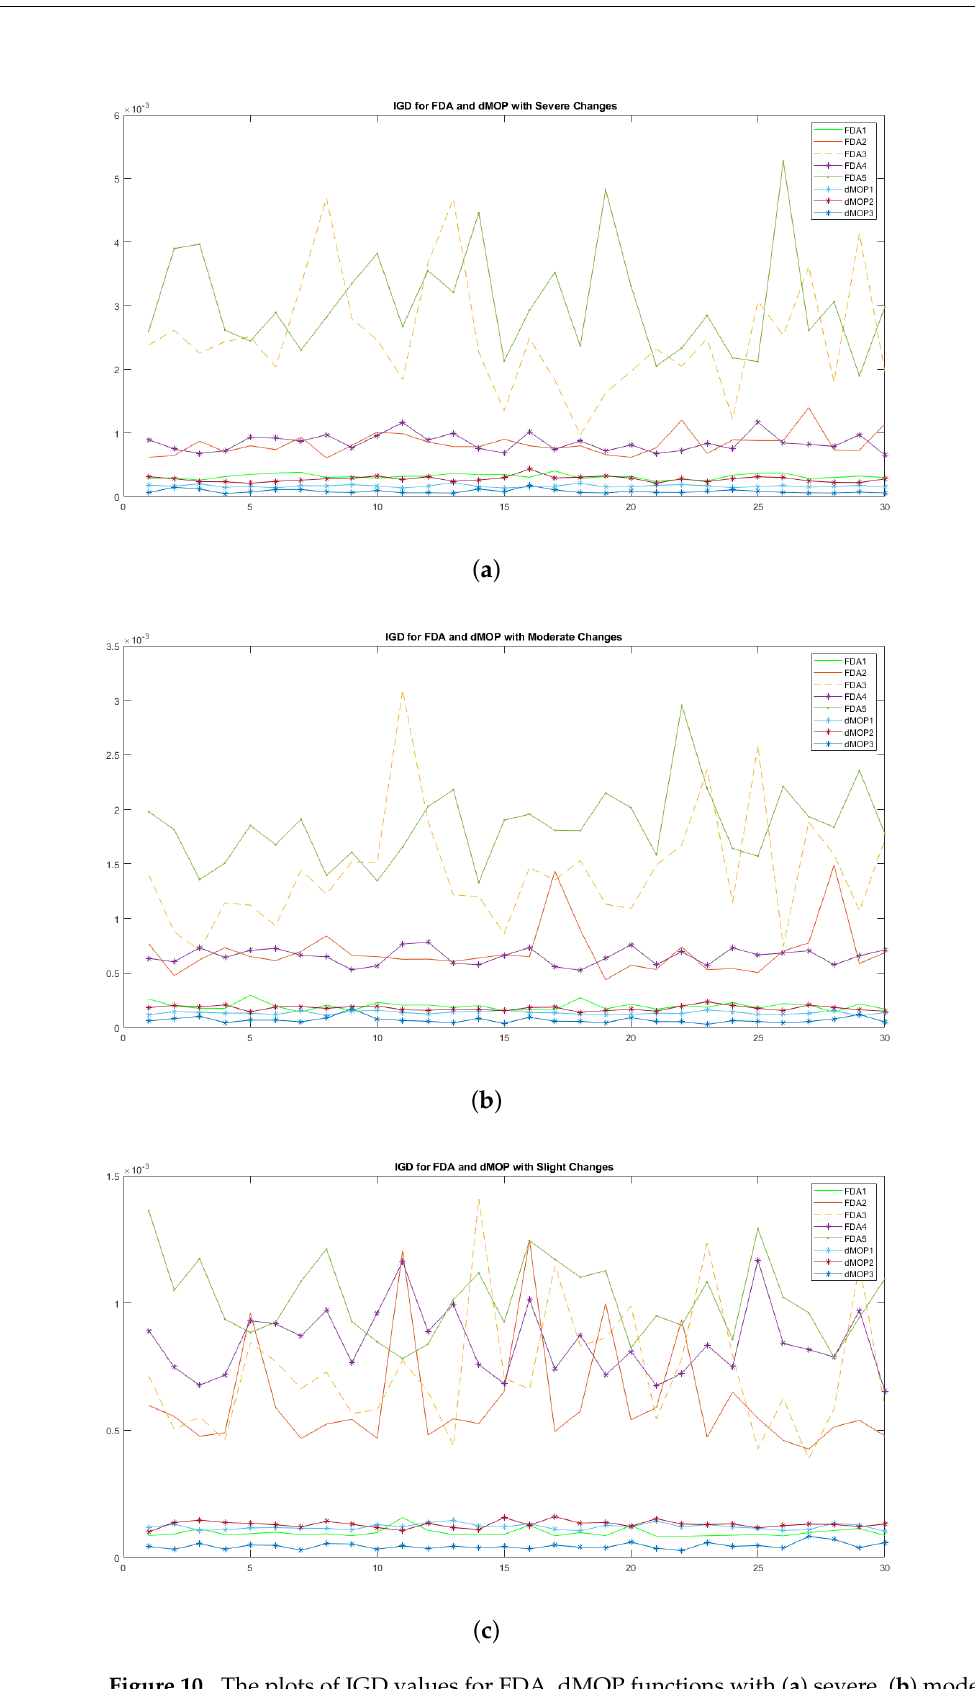
Figure 10. The plots of IGD values for FDA, dMOP functions with ( a ) severe, ( b ) moderate and ( c ) slight environmental changes using the DB-CSA